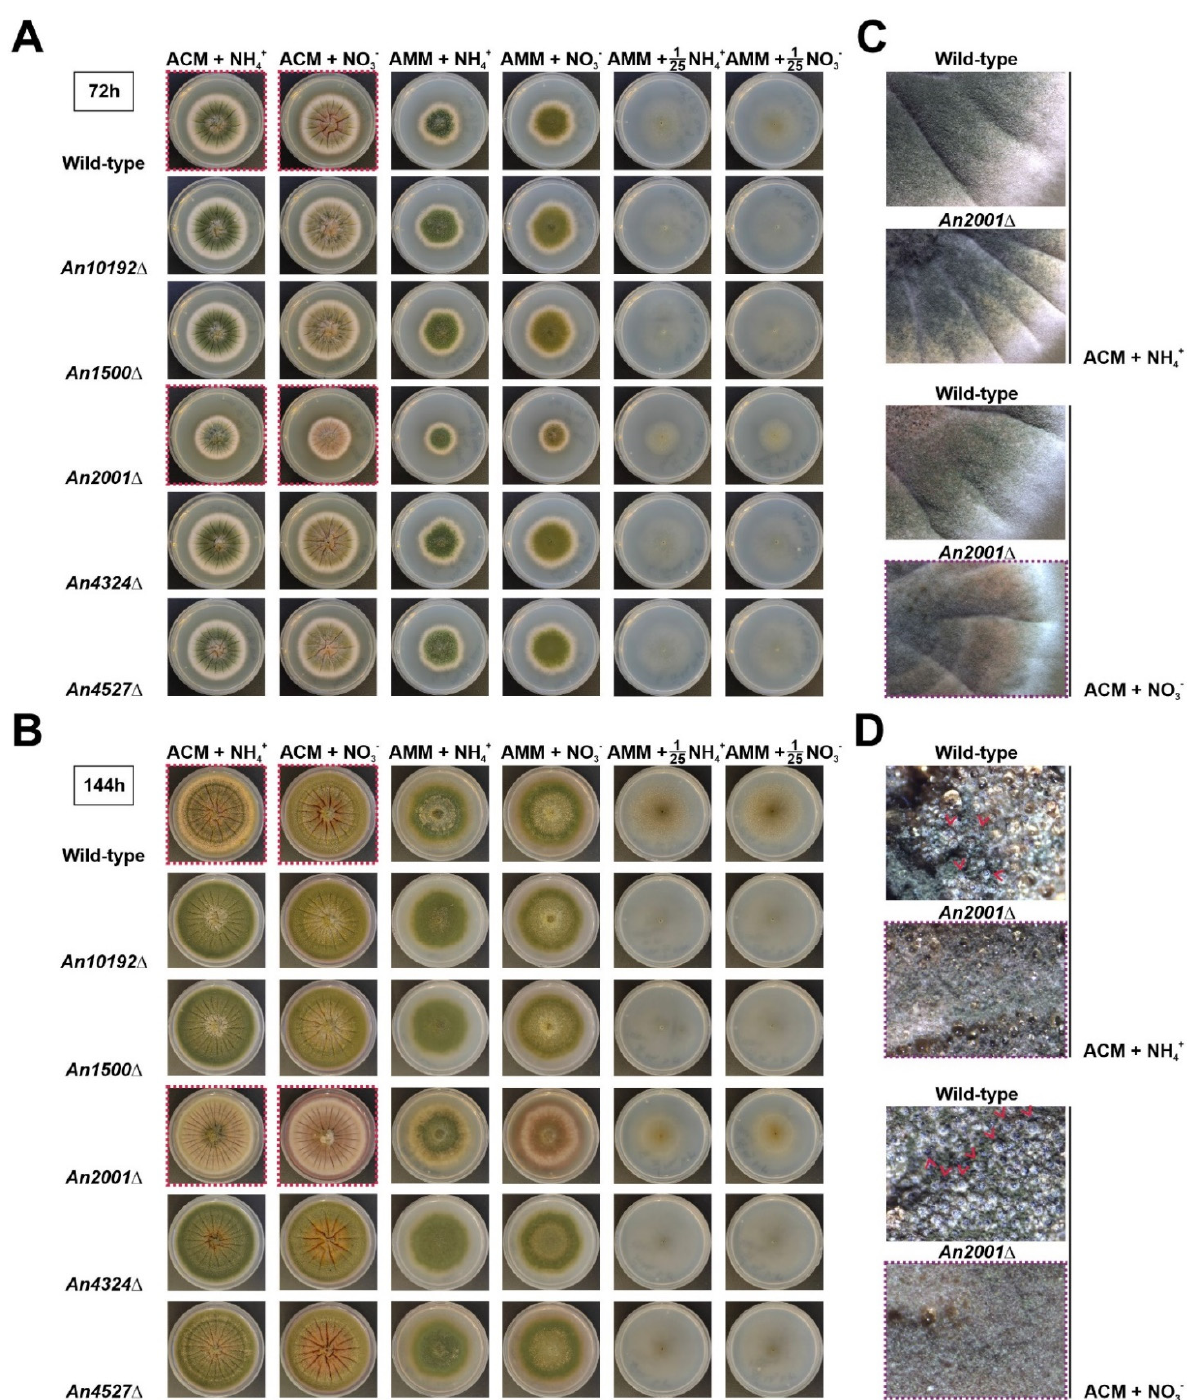
Figure 8. Phenotypes of single-null mutant strains of five TF-coding genes potentially necessary for A. nidulans development. Phenotypes of the null mutants in ACM ( Aspergillus complete medium) or AMM supplemented with ammonium (first and third columns, respectively) or nitrate (second and fourth columns, respectively), after 72 ( A ) or 144 h ( B ) of culture at 37 ◦ C, and compared to the parental wild-type strain. The phenotypes of the same strains under nitrogen limitation (1/25 dilution of the nitrogen source compared to AMM) are shown in columns five and six, respectively. The diameter of plates is 5.5 cm. Red squares indicate the colonies amplified in the images shown in panels ( C ) (72 h of culture) and ( D ) (144 h). Red arrowheads highlight cleistothecia.